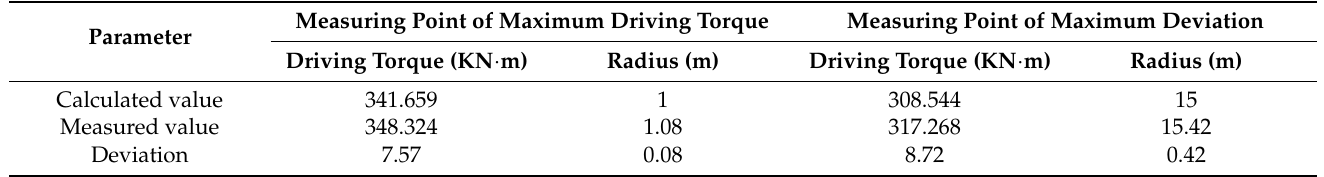
Figure 8. Experimental data of turning motion on slope, (a) Driving Torque of Calculation and Measuring, (b) Deviation Torque.